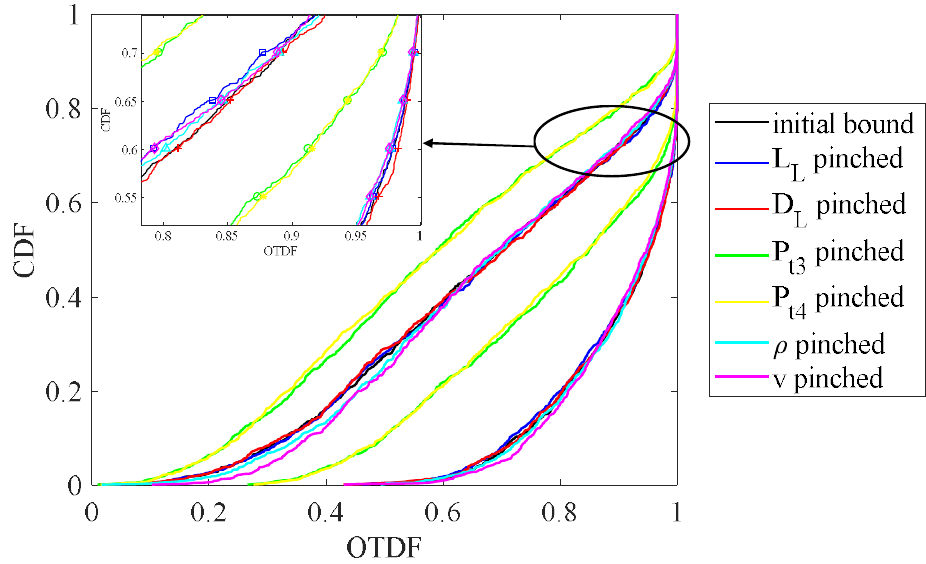
Figure 15. P−boxes for OTDF with diverse correlated inputs pinched. Figure 15. P-boxes for OTDF with diverse correlated inputs pinched. Table 4. Areas of the p-box of OTDF and the sensitivity index S of the corresponding input